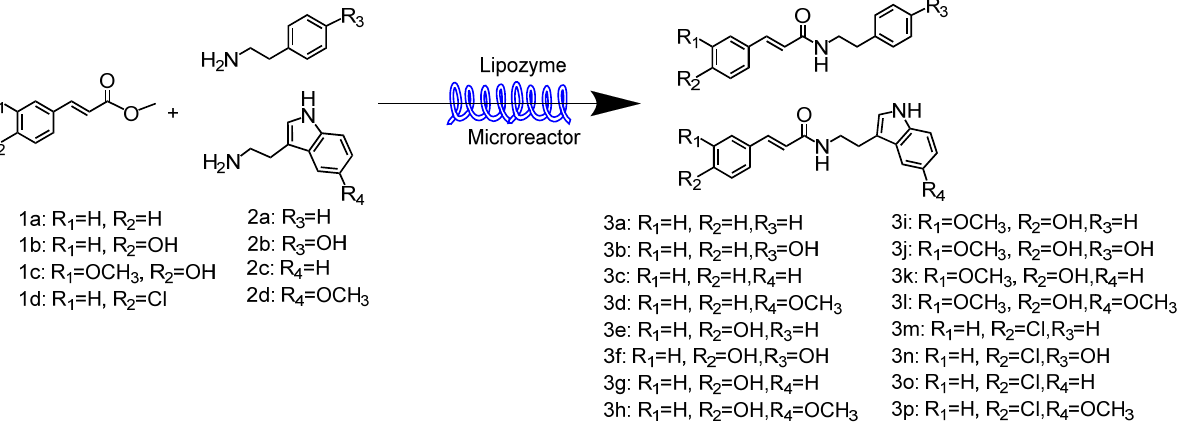
Table 1. The effect of reaction media and catalyst on the enzymatic synthesis of N-phenethylcinna- mamide in continuous-flow microreactors a